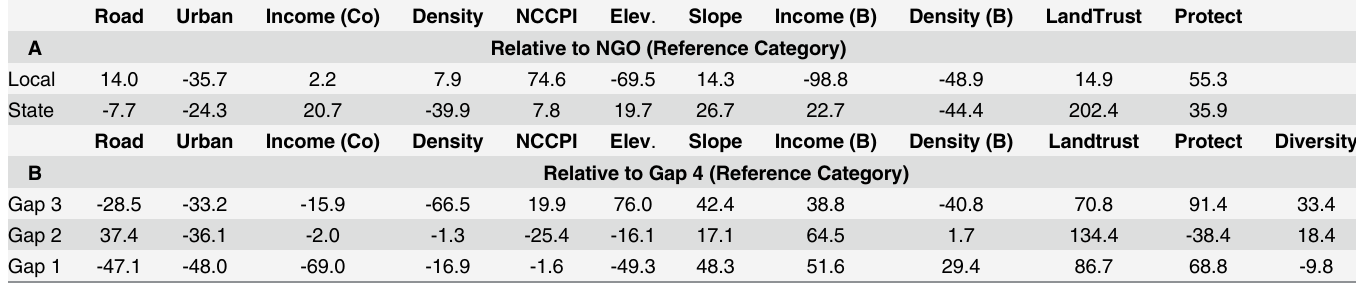
Values are percent change in the odds of moving from the reference category to the test category (groups A or B) for a one-unit increase in each variable. The effect size and direction can be interpreted as a greater, negative % change in odds means as the value of the variable decreases (e.g., closer to feature, or lower in elevation), the odds of being in the reference category decrease relative to the odds of being in the test category, and the reference category would be farther from, or lower than, the test. Federal holders not included in analysis A due to their very small numbers. Only predictors that were signi fi cant in top models are shown (e.g., Diversity in Analysis